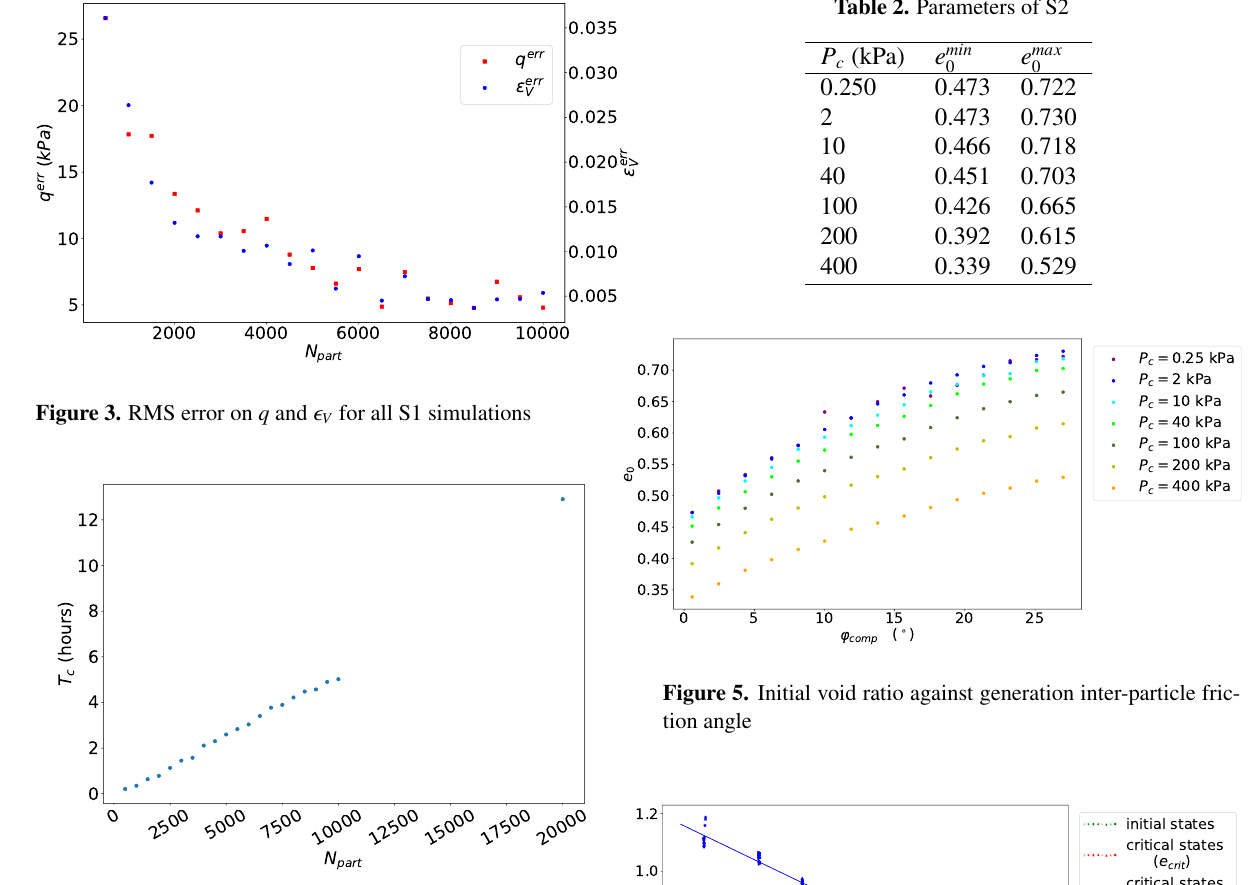
Figure 4. Time costs for all S1 simulations